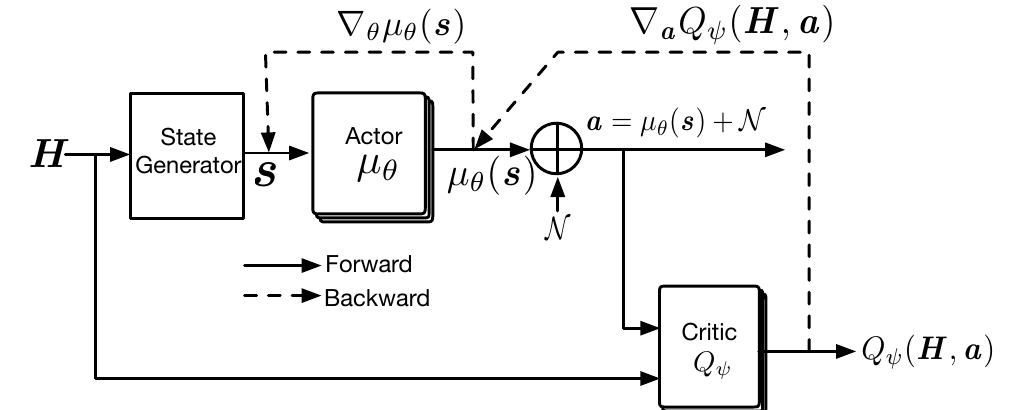
Figure 2. Architecture for training DDPG in the proposed power control